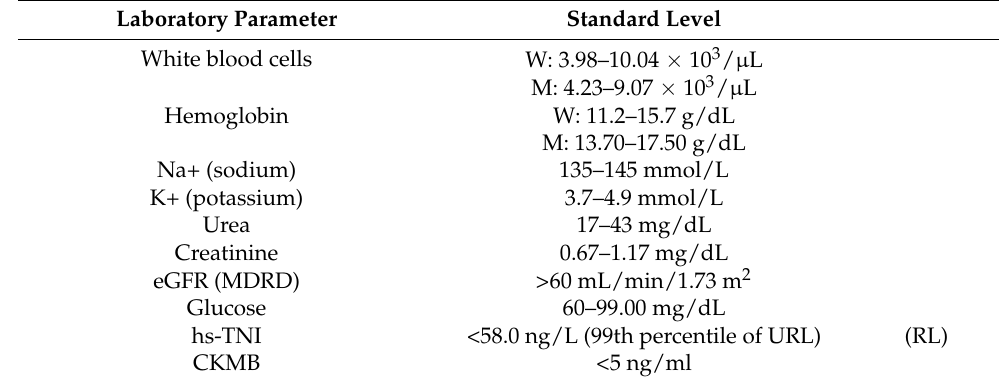
Table 1. Standard levels of selected laboratory